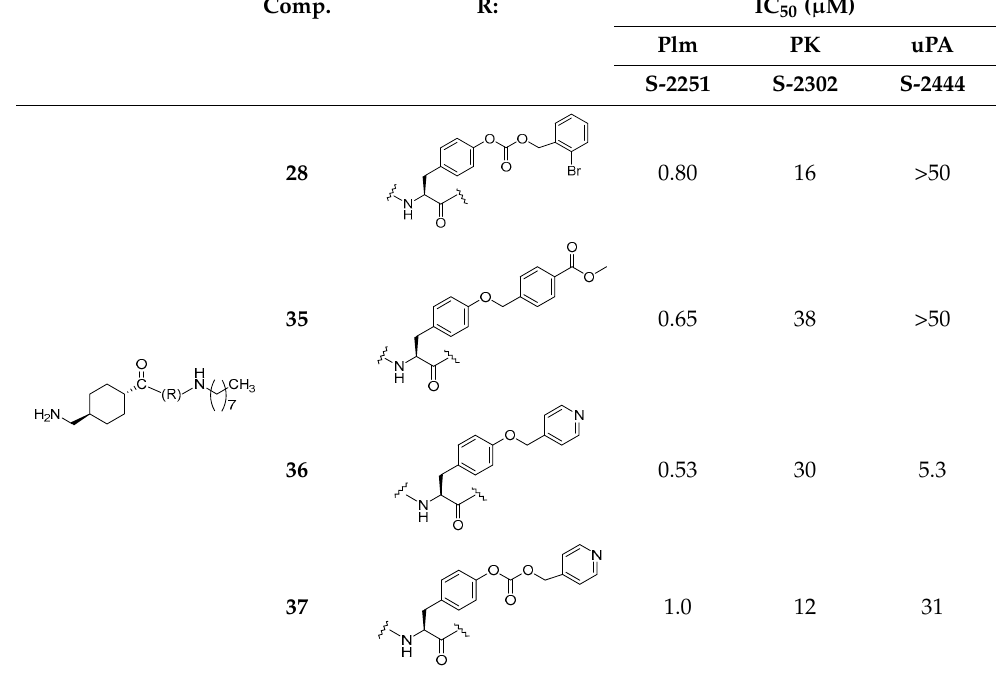
Table 8. Inhibitory activity of compounds 28 [31] and 35–37 [13] against various proteases. Comp.